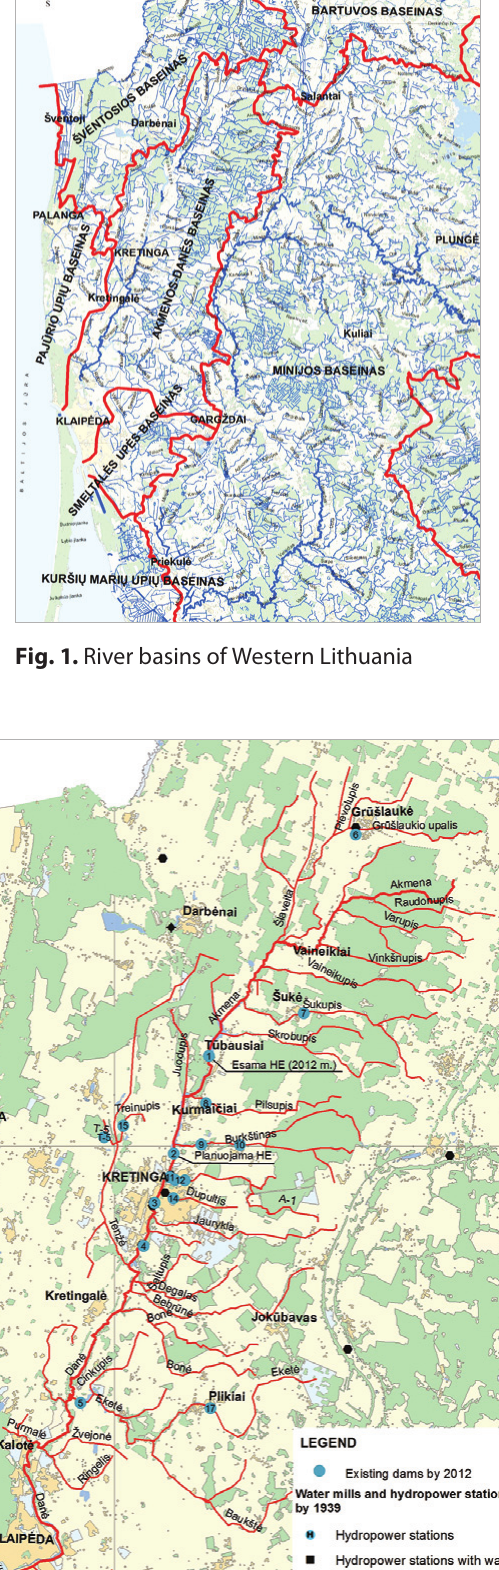
Fig. 2. Hydrographic network of the Akmena-Danė river basin (present hydrotechnical impoundments are marked by tick marks with the relevant number)